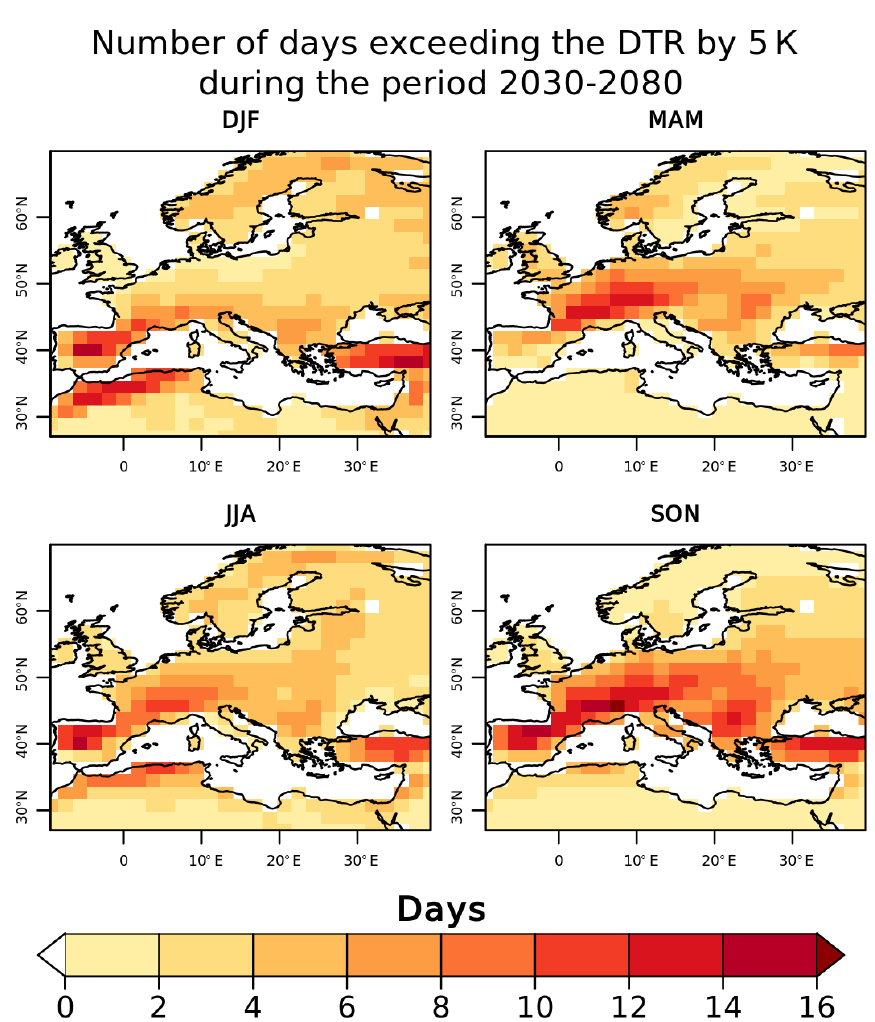
Figure 10. Average number of days per year exceeding the diurnal temperature range (DTR) of the historical period (1961–1990) by 5K during the period 2030–2080. The example shown is calculated for the RCP8.5 scenario simulated by MPI-ESM-MR (see Sect. 3.3.3 for details on recipe_diurnal_temperature_index.yml